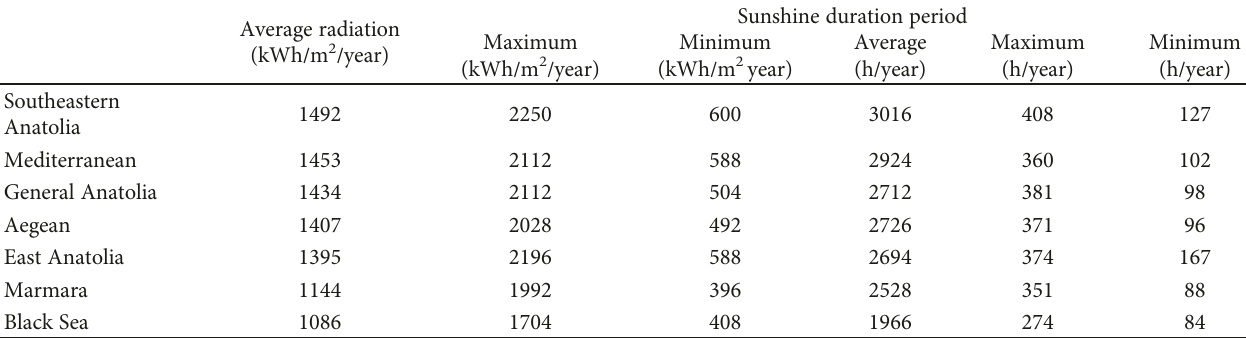
Table 1: Solar energy potential for subregions in Turkey [16].